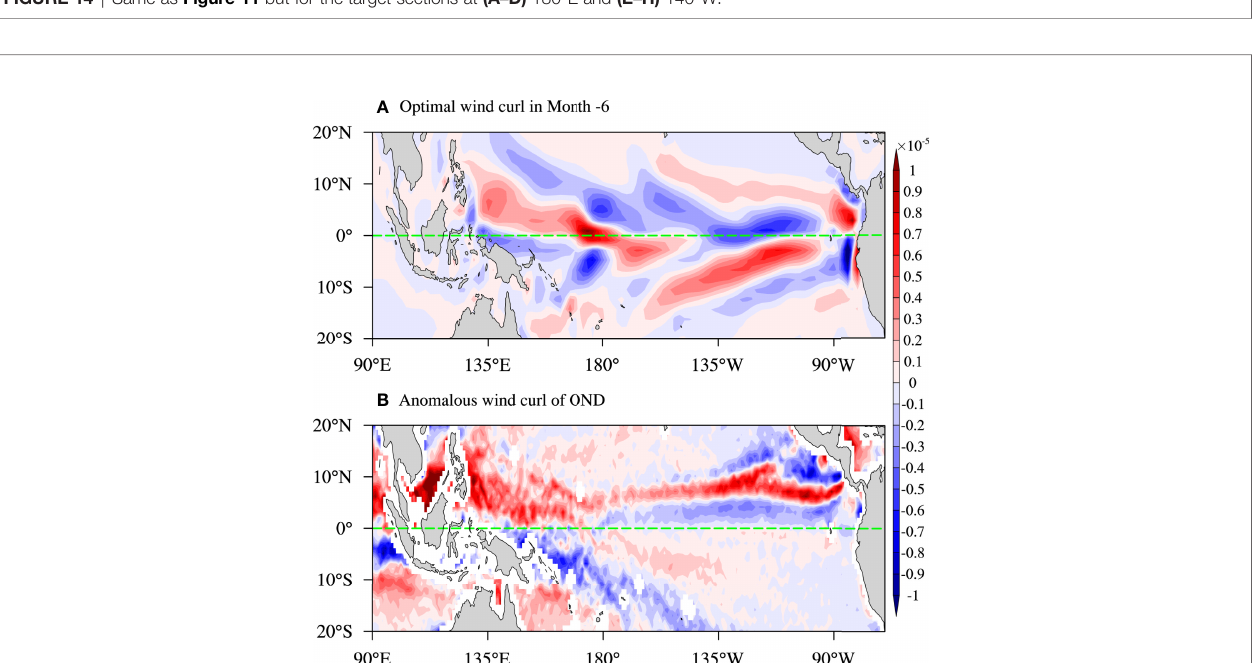
FIGURE 15 | The comparison of the (A) sensitivity-like wind curl (s -1 ) at month – 6 and (B) the wind curl anomalies averaged at winter months (October to December) during 2000-2008 from the QuikSCAT satellite